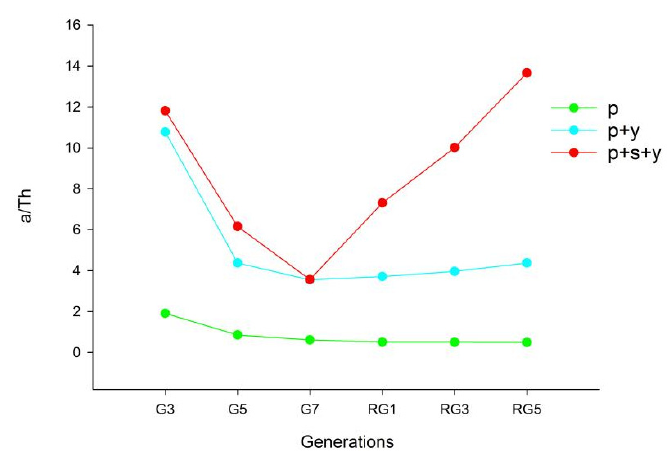
Figure 5. The effect of different treatments on predation capacity (a/Th). The search effect decreased with an increase in density for the same treatment con- ditions and generations and followed the pattern of pollen group < pollen + yeast